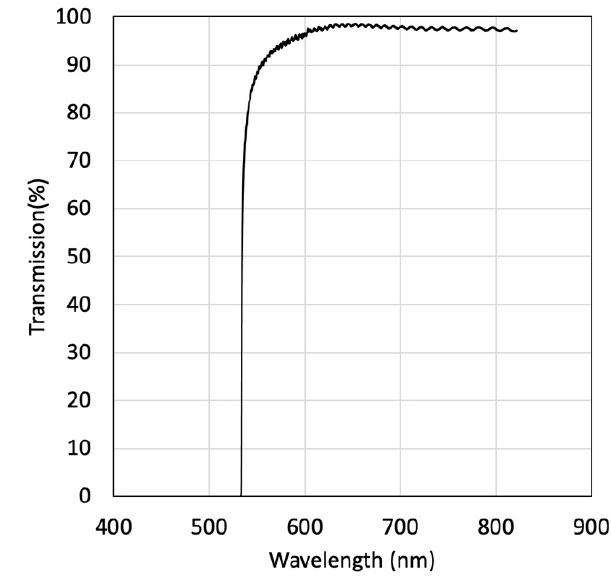
Figure 4. Example transmission curve of an edge filter that cleans lines below 532 nm.